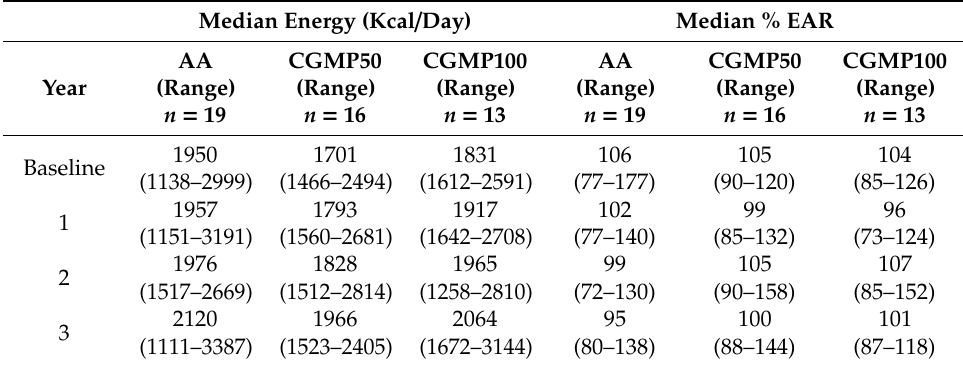
Table 2. Median daily energy intake (range) and %EAR (range) for AA, CGMP50 and CGMP100 from baseline to year